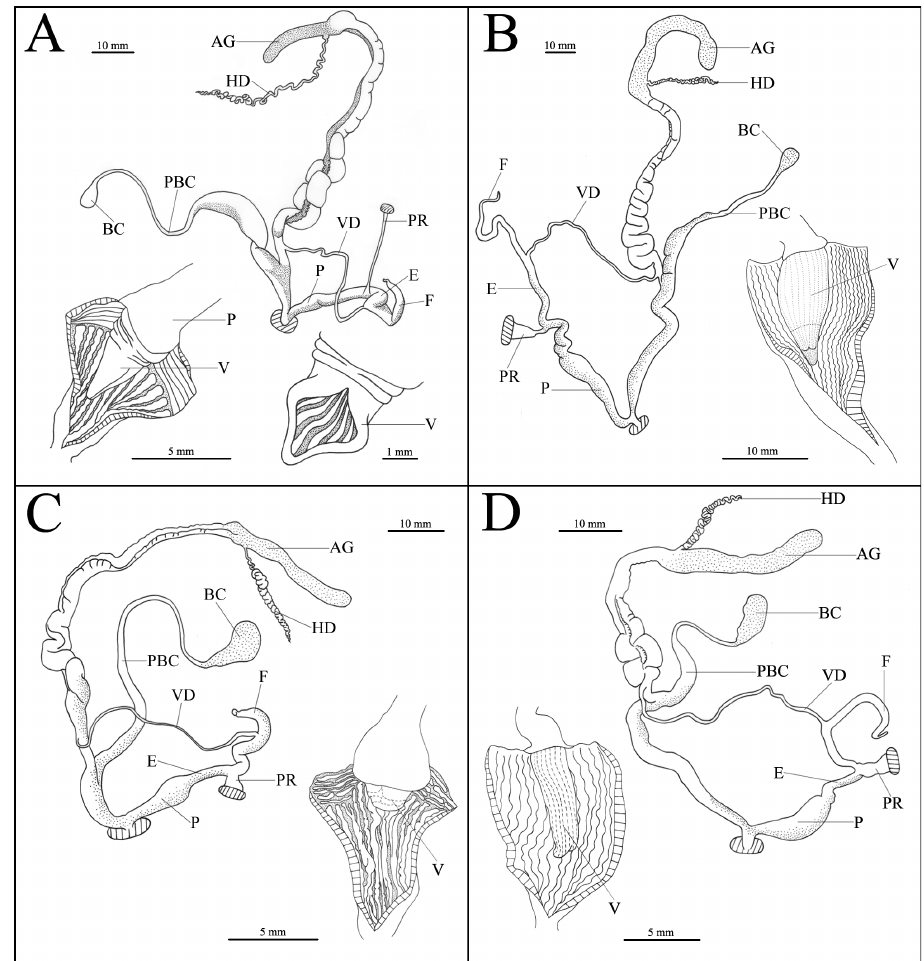
Figure 4. Reproductive system. A Camaena lingyunensis sp. n. (holotype, FJIQBC 19280, Kasuo, Ling- yun, Guangxi, China) B Camaena detianensis sp. n. (holotype, FJIQBC 18472, Detian Falls, Daxin, Guangxi, China) C Camaena hahni (FJIQBC 19301, Huu Lien Nature Reserve, Lang-Son, Vietnam) D Camaena cicatricosa (FJIQBC 18505, Guiping, Guangxi, China). Abbreviations: V, verge; AG, albu- men gland; BC, bursa copulatrix; E, epiphallus; F, flagellum; HD, hermaphroditic duct; P, penis; PR, penis retractor muscle; PBC, pedunculus of bursa copulatrix; VD, vas deferens.